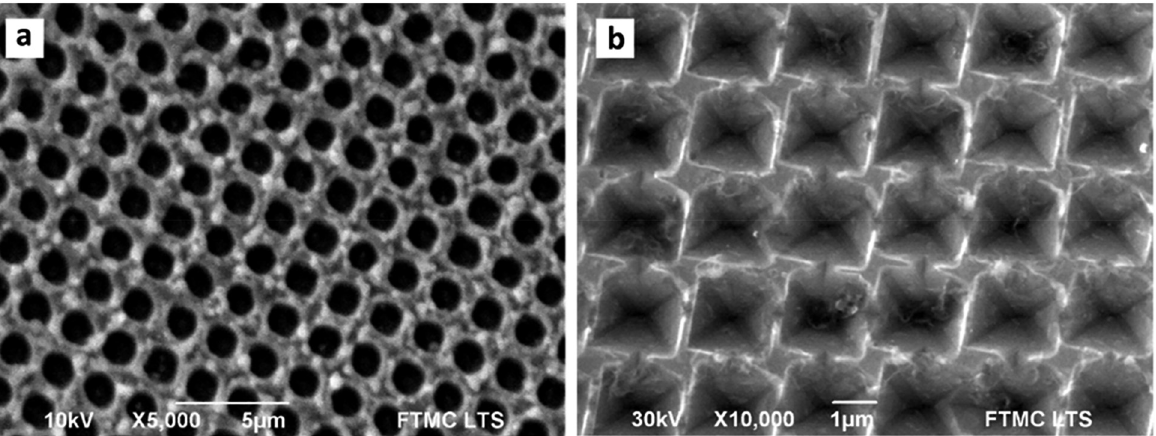
Figure 17: SEM images of a silicon wafer structured by (a) four-beam DLIP and (b) by post-laser chemical etching with controlled anisotropy. Reproduced from ref. [159] (© 2014